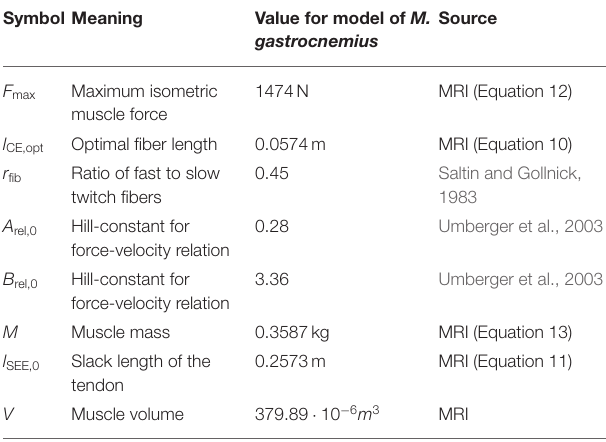
TABLE 1 | Subject specific model parameters.